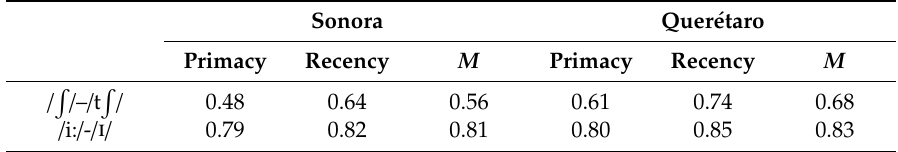
Table 2. Proportion of correct responses by learner group (Quer é taro, Sonora), as a function of lexical contrast ( seat – sit , / i: / -